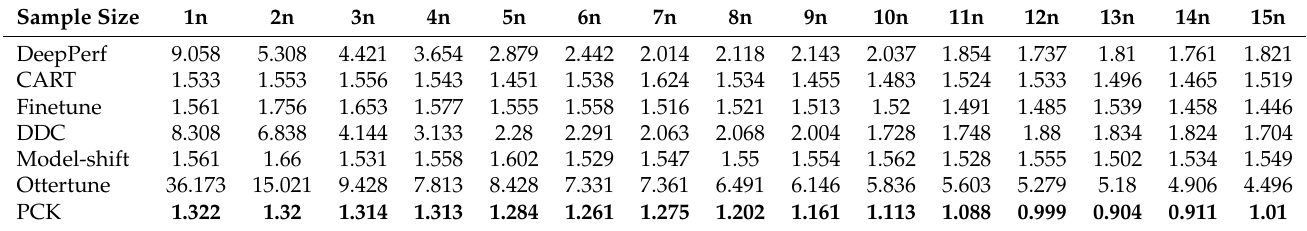
Table 9. MRE comparison among different approaches for Redis (version 4.0.1–5.0.0). Sample Size